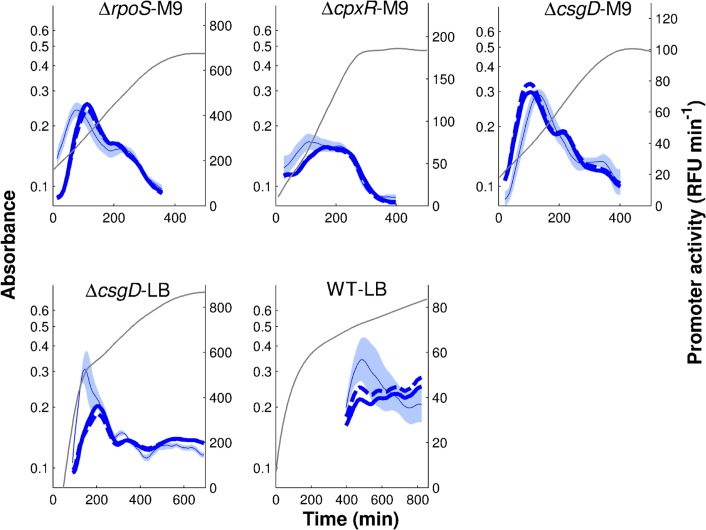
Regulation function of tar fitted to reporter gene data when reconstructing protein concentrations from the reporter gene data for physiologically realistic half-lives and including global physiological effects.As in Fig. 10, but the half-lives have now also been estimated from the data, within a physiologically plausible range. Model predictions are in thick solid and dashed blue lines, tar reporter data are in light blue (thin line and shaded area). Two example fits are shown, namely the best fit for estimated half-lives of FliA and FlgM (solid line, Q = 21.0, (k
0,k
1,n,θ,K) = (0.22,6.6,1.38,6252,47467)) and another example of a high-ranking fit (dashed line). In the case of the best fit, the half-lives of FliA are equal to (60,30,24,30,60) min in the (ΔrpoS, ΔcpxR, ΔcsgD-M9, ΔcsgD-LB, WT-LB) conditions, respectively, while the half-lives of FlgM are equal to (45,7,24,11,9) min. Confidence intervals for the parameter values are reported in Text S10.